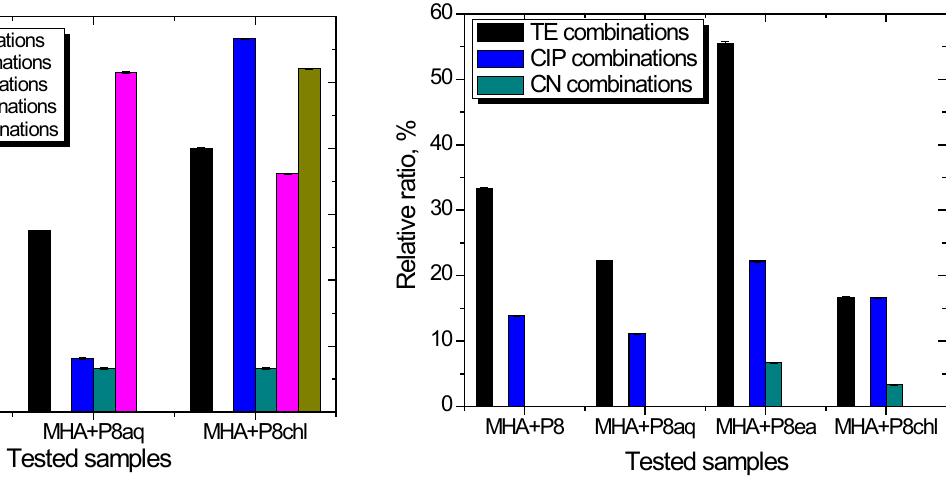
Figure 8: S. aureus ATCC 6538 response.